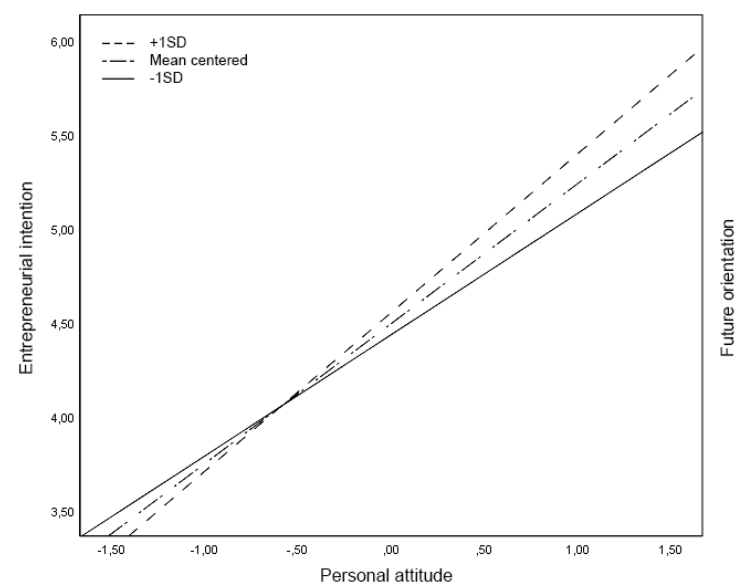
Figure 1. Relationship between personal attitude and entrepreneurial intentions for different levels of future orientation Table 6. Moderation effect of future orientation in the emancipation- entrepreneurial intention relationship (via attitude)